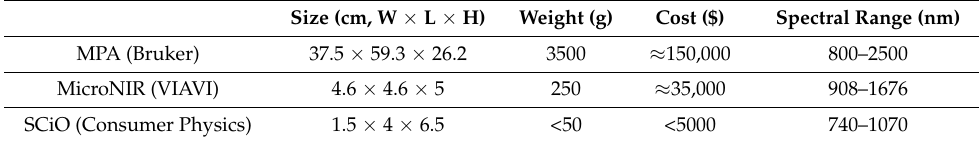
Table 1. List of the main technical near-infrared (NIR) spectrometers’